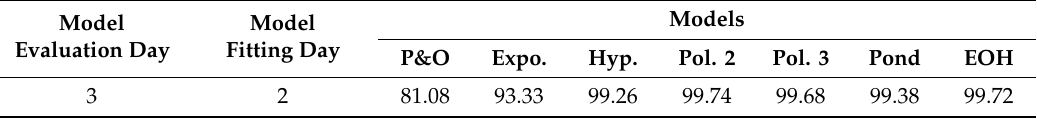
Table 5. Obtained performances (percentage of tracking e ffi ciency) with highly variable load.